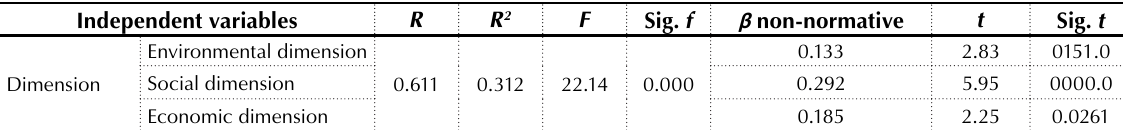
Table 6. Results of the second sub-hypothesis